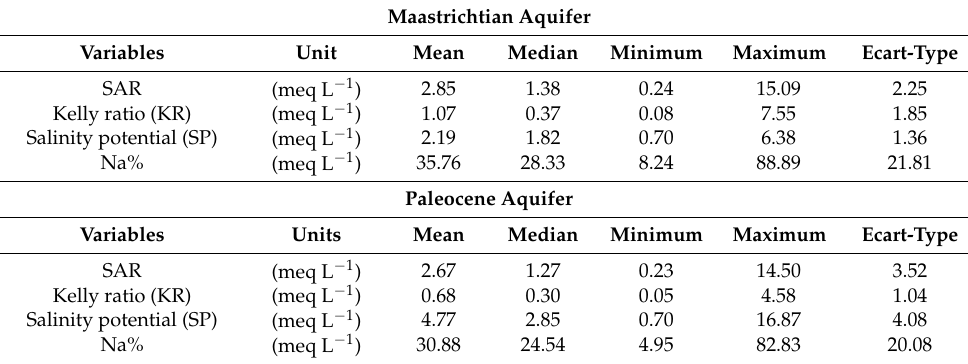
Table 6. Summary of geochemical classification of irrigation indices.